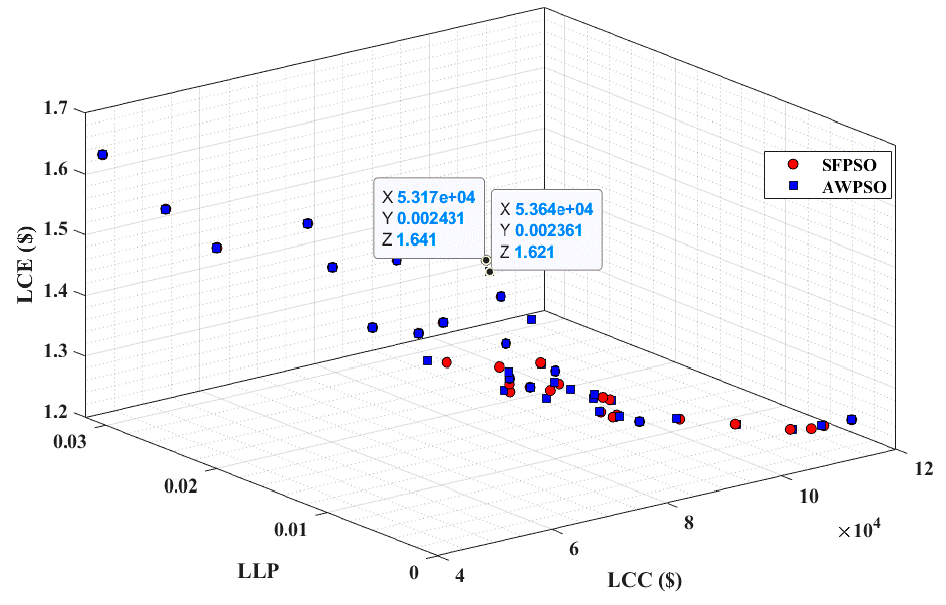
Figure 13. Evaluation of life cycle cost (LCC), LLP, and levelized cost of energy (LCE) values with different weights sets.